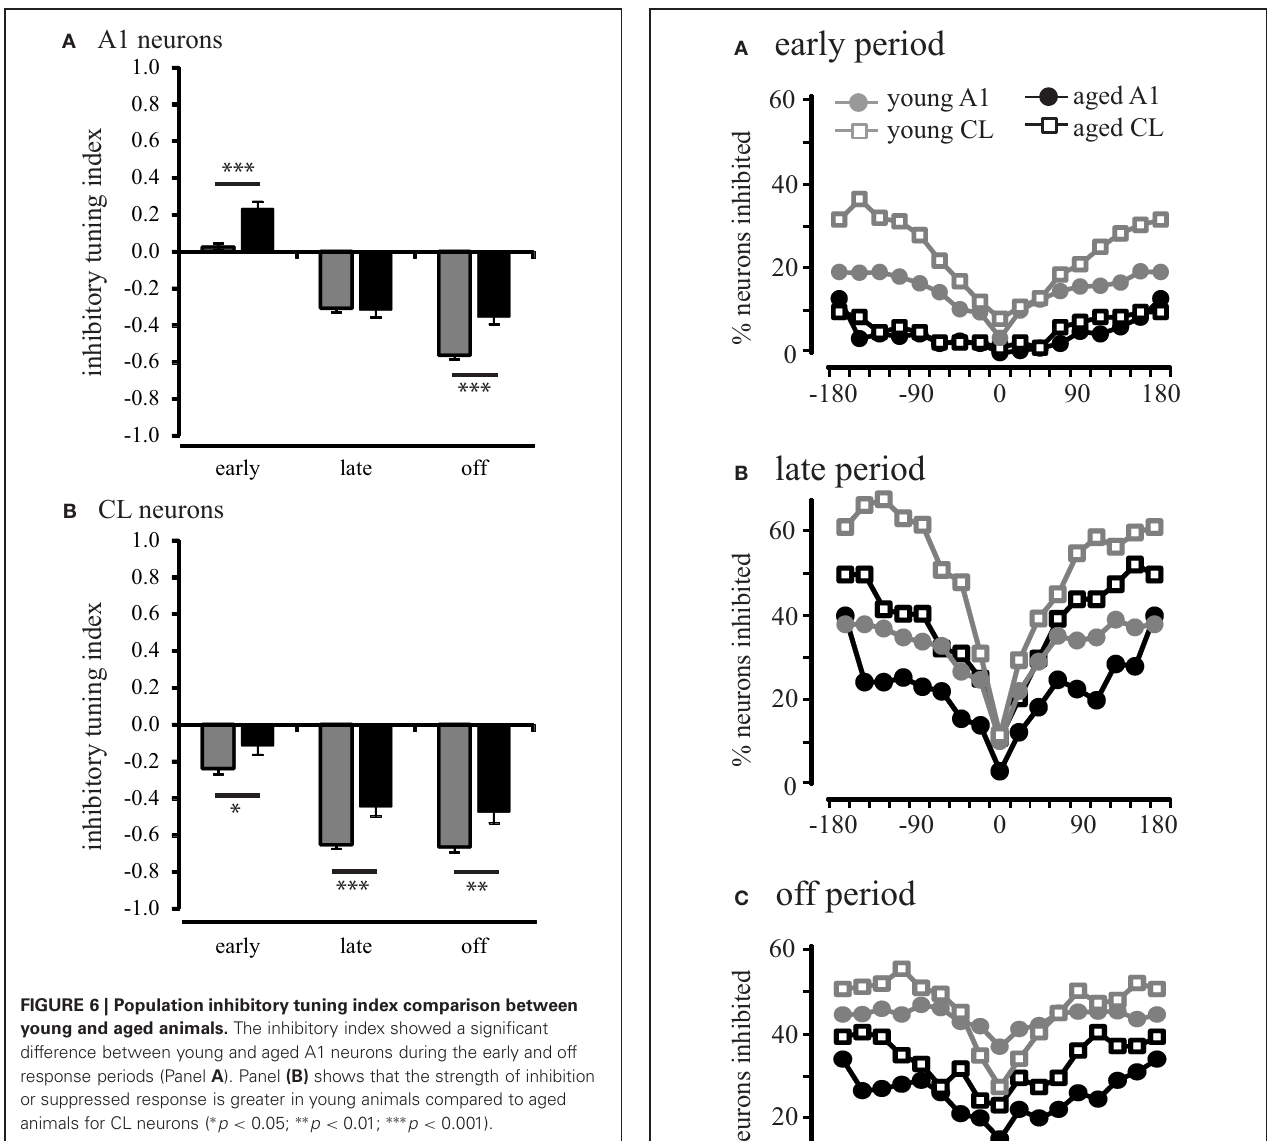
A1 were less suppressed during the early [ F ( 1 , 1276 ) = 25 . 95, p <